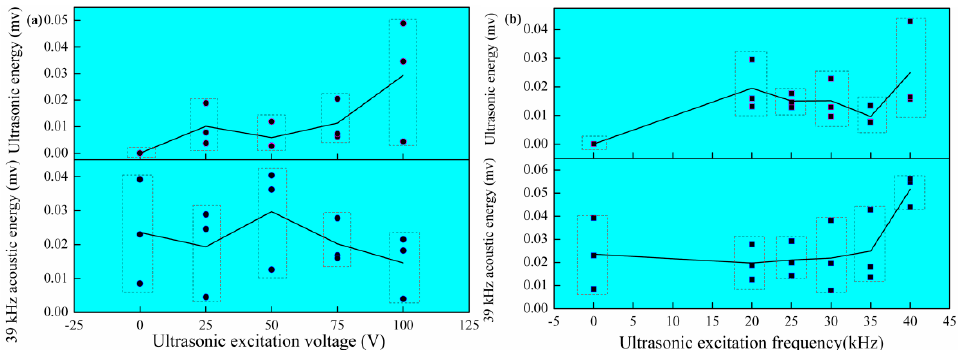
Figure 5. The acoustic energy with different ultrasonic excitation: ( a ) ultrasonic excitation voltage; ( b ) ultrasonic excitation frequency.